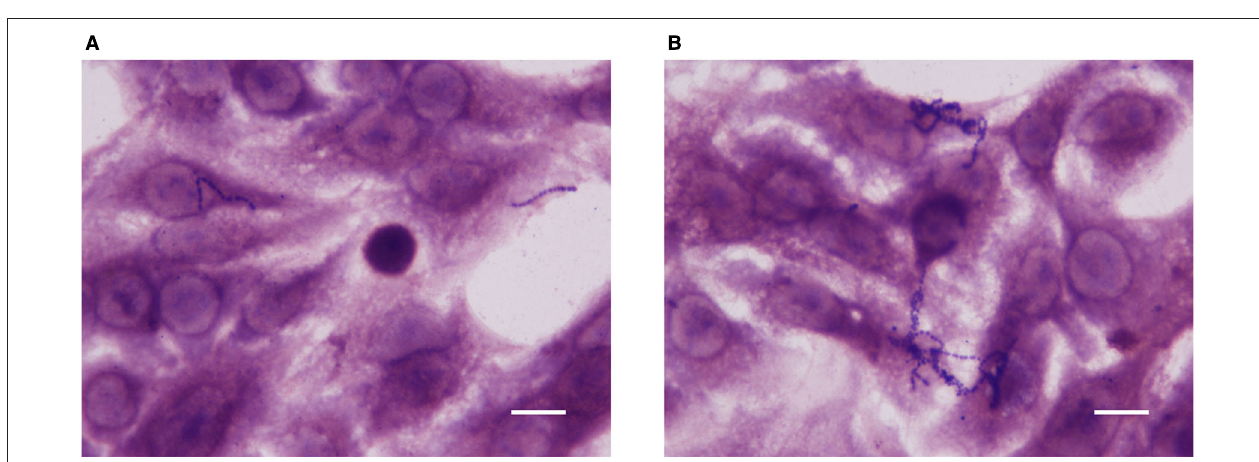
FIGURE 2 | Adhesion/invasion of A549 cells by strain SP1070 grown in presence of capsaicin sub-MICs. (A) adhesion; (B) invasion. Results are the mean of adherent or intracellular streptococci (CFU/mL (cid:6) SD) of two experiments. Asterisks denote significant values with respect to the control ( p (cid:20) 0.05).